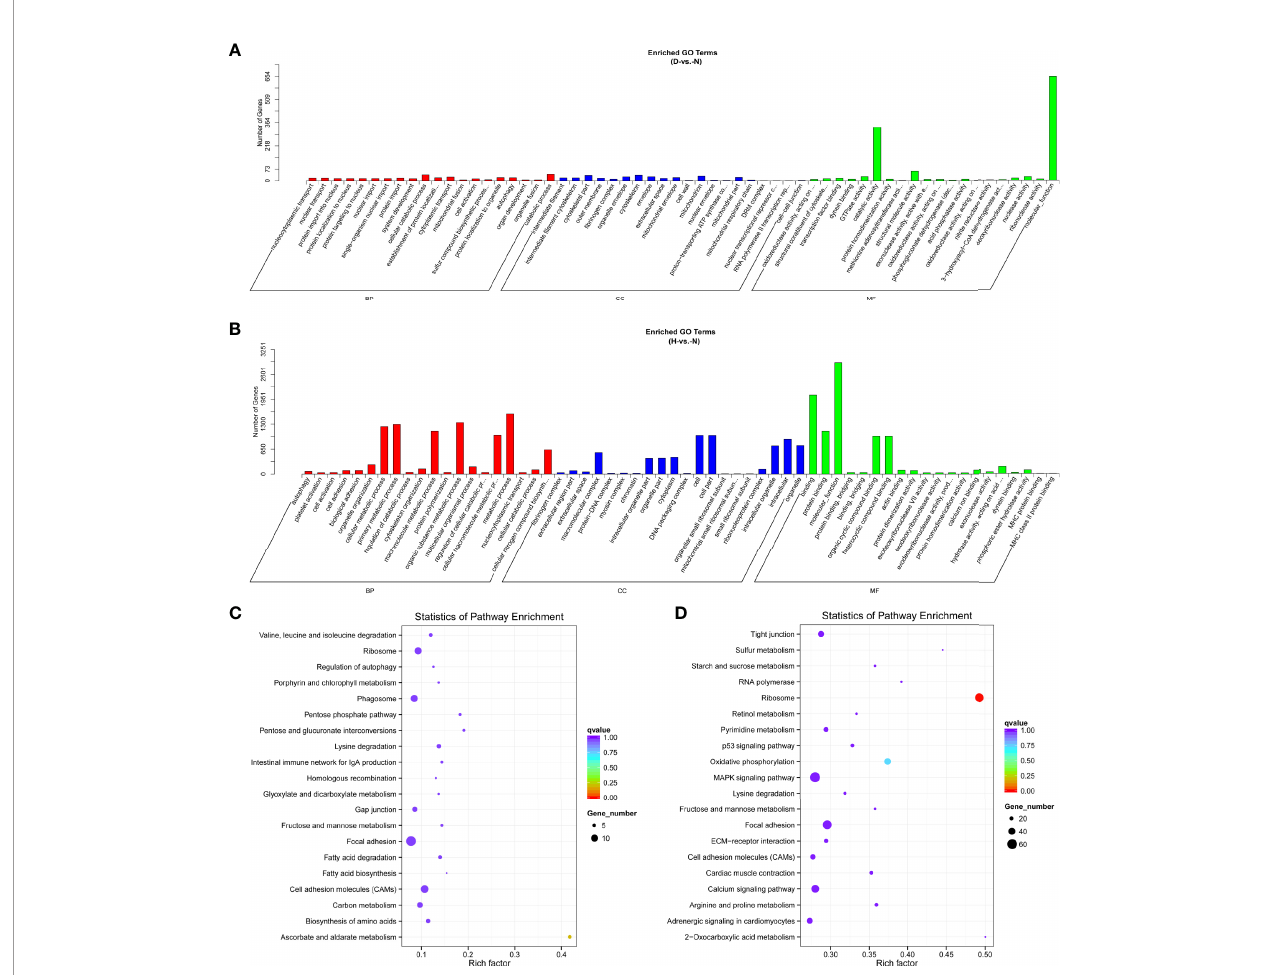
FIGURE 4 | GO functional classi fi cation based on DE miRNA target genes of D-vs.-N group (A) and H-vs.-N group (B) . GO terms distribution of target genes under molecular functions, cellular components, and biological processes. The X-axis represents the enrichment GO terms and the Y-axis represents the number of genes. KEGG analysis of the top 20 enriched pathways based on the target genes of D-vs.-N group (C) and H-vs.-N group (D) . The Y-axis represents enrichment factor, the X-axis represents enrichment, and the size of the solid circle indicates the number of